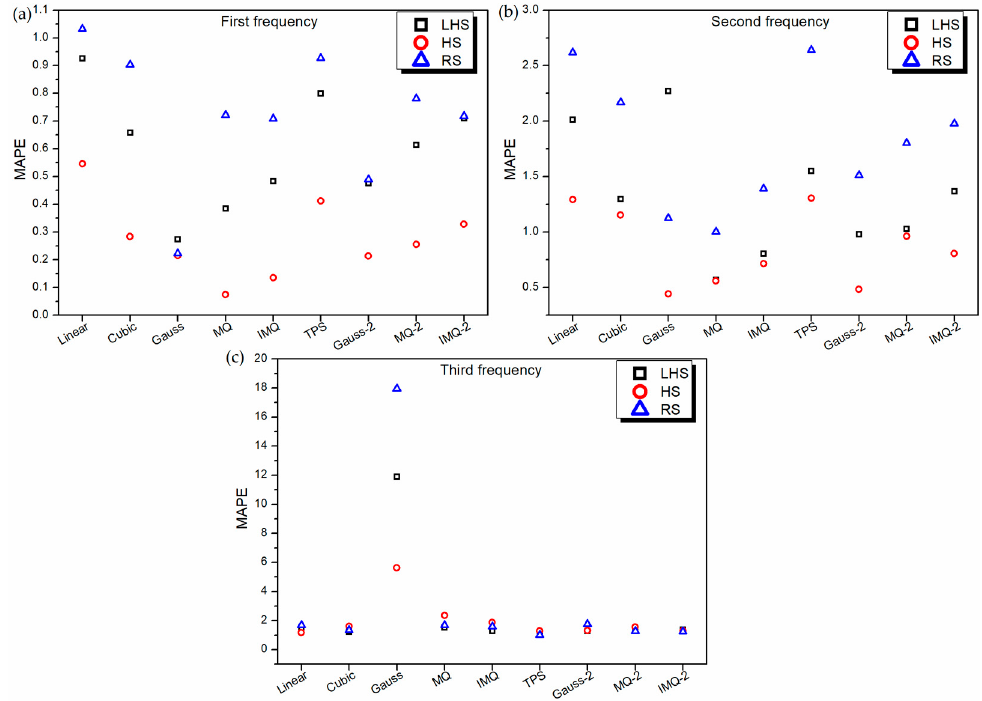
Figure 6. MAPE values of various RBF metamodels in LD problem for testing data.